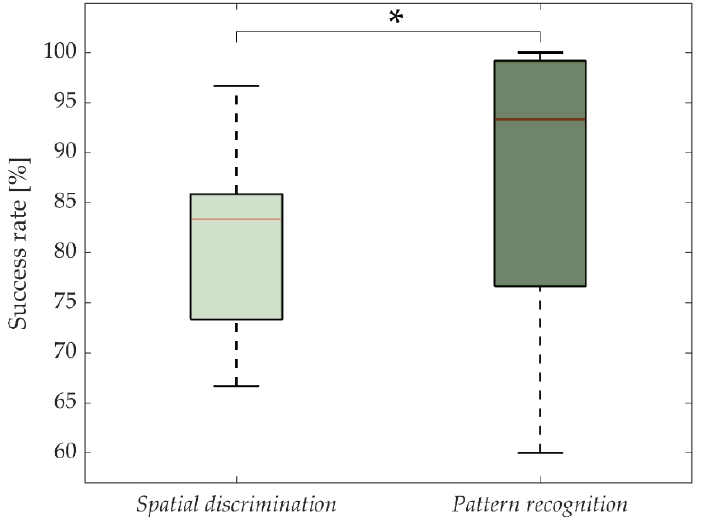
Figure 4. Success rate in spatial discrimination of a single pad within the six-pad electrode (static encoding) versus movement pattern recognition (dynamic encoding). The red lines and boxes indicate the median and interquartile range, respectively. The asterisk indicates significant differences (*: p < 0.05).